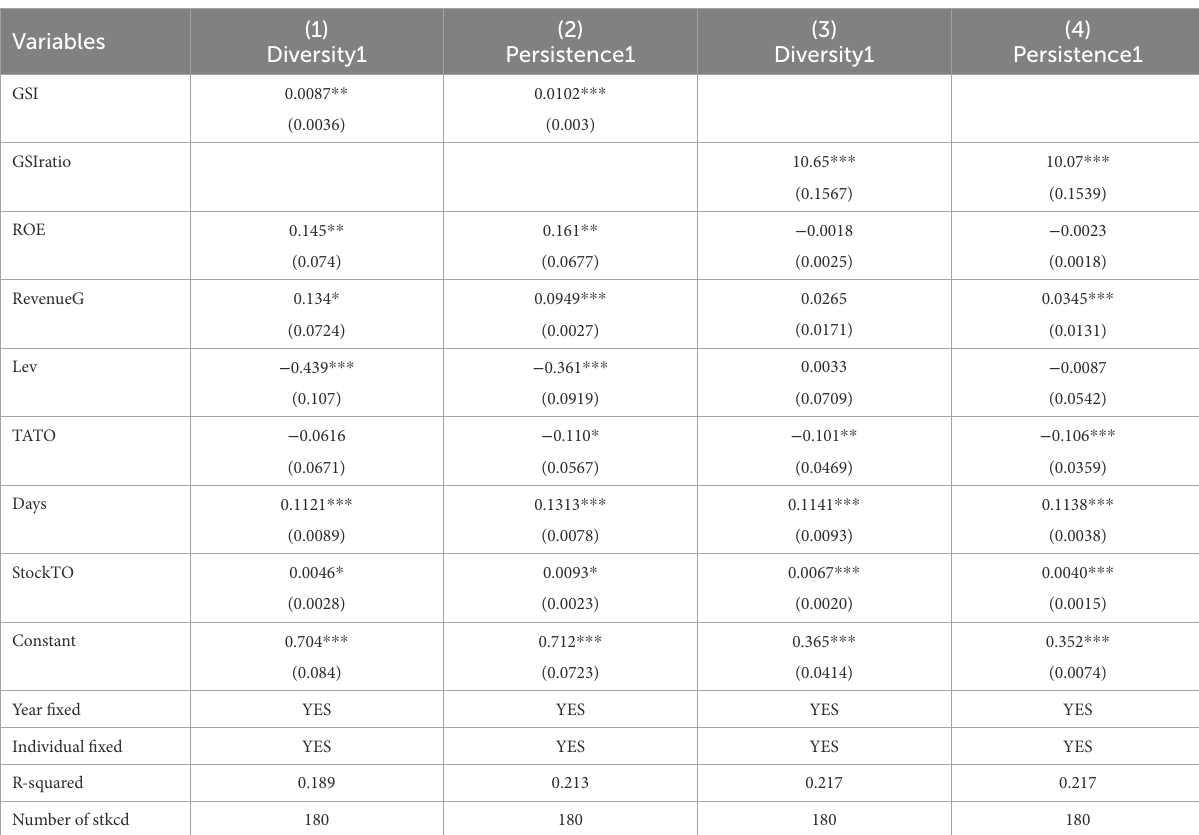
TABLE 4 Robustness tests of replacing independent variables and dependent variables.